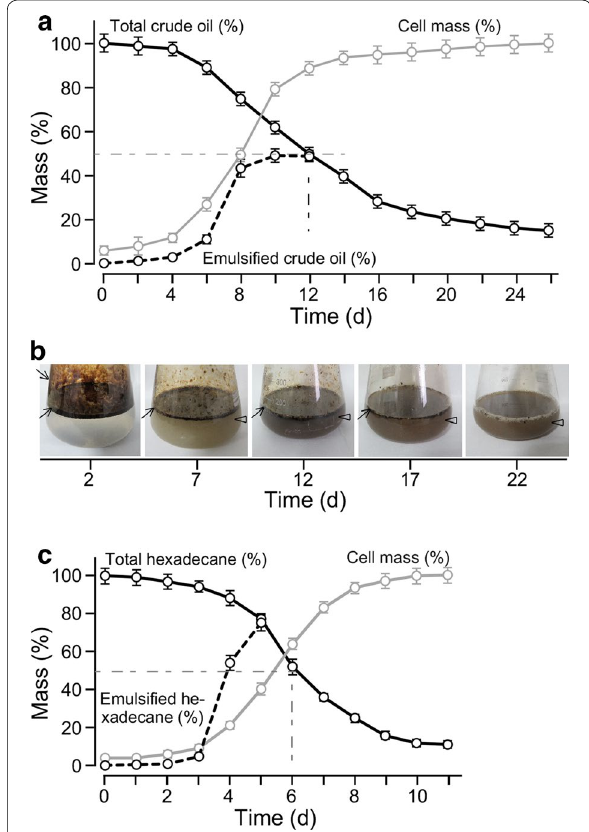
Fig. 6 ZS1 growth in medium with crude oil as sole carbon source. a Growth curve analysis of ZS1 isolate in MS medium supplemented with 1% crude oil. X- and Y-axis indicate time (days) and percent of mass (%) of crude oil or cell biomass. Maximum level (or 100%) of crude oil and cell biomass are 10 and 6.5 g/l, respectively. Dash-line indicates 50% crude oil remained after growth for 12 day. b Degrada- tion of crude oil by ZS1 isolate. Images show crude oil in shake-flask containing ZS1 culture at various time points during growth. Arrow- head and arrow indicate the unemulsified and emulsified crude oils, respectively. c Growth curve analysis of ZS1 isolate in MS medium supplemented with 1% hexadecane. The display is identical to